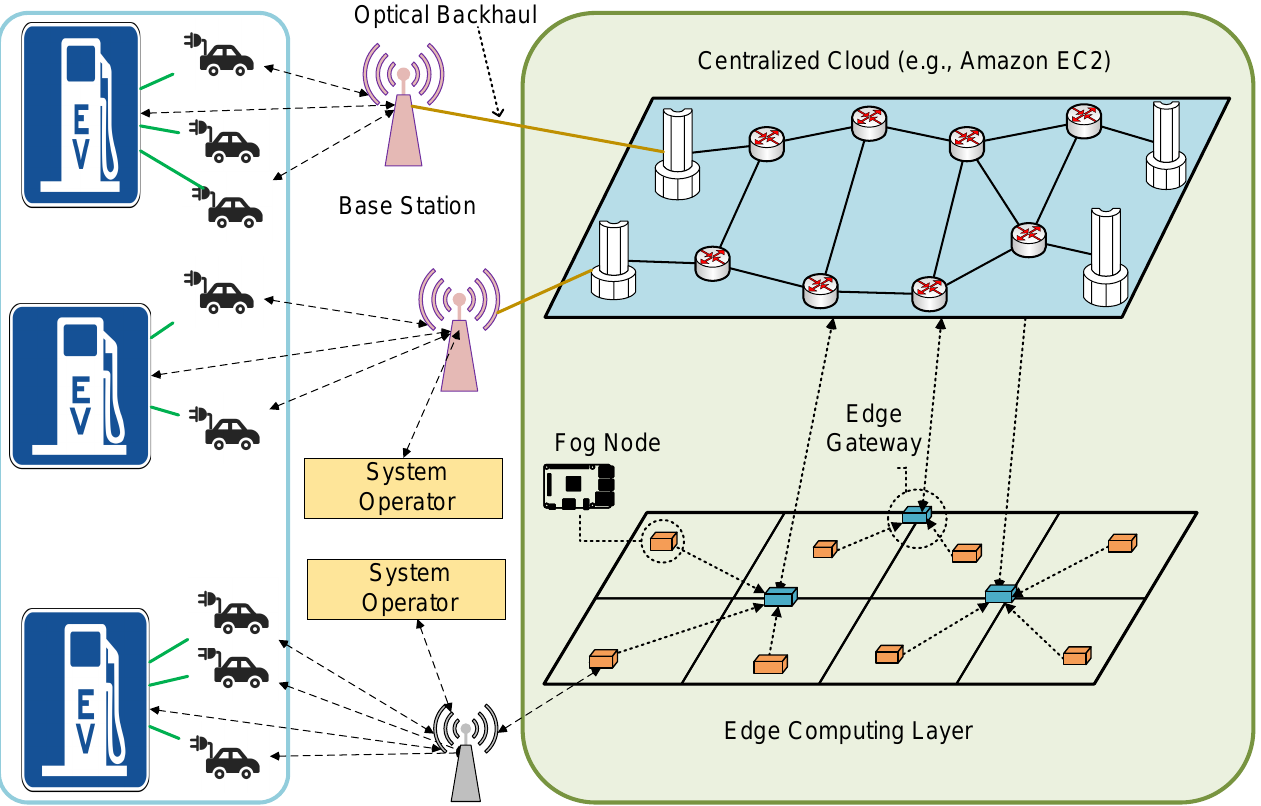
Figure 2. Network architecture of two-tier cloud computing-based EV charging management system in